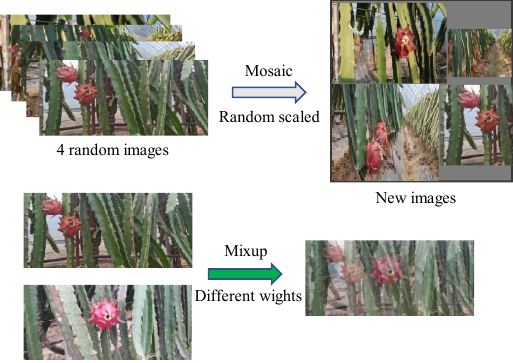
Figure 1. Process of mixup and mosaic data augmentation.